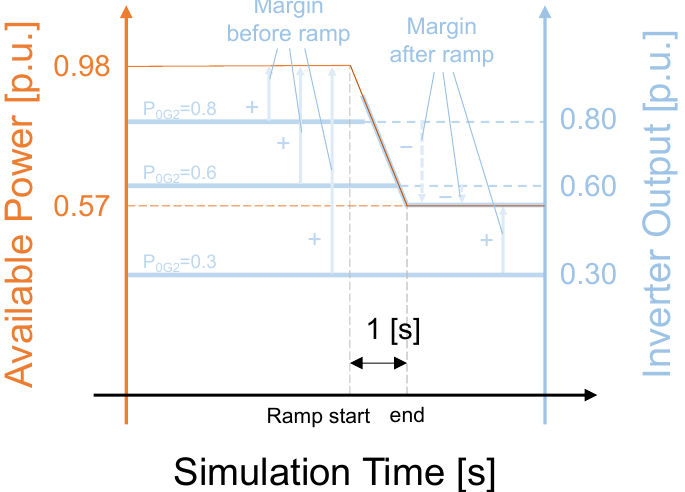
Figure 13. The change in available power and inverter output before and after the ramp change. The output of the inverter without ESS should be limited to the available power, and when the upper limit falls below the initial output before the ramp, the limiter control should be activated to suppress the